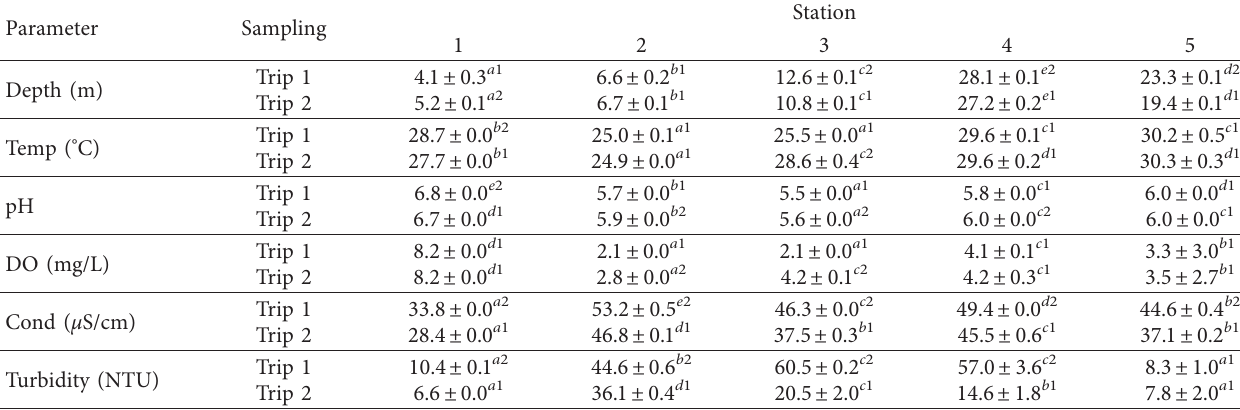
Table 4: In situ water quality of the Murum River during the dry (trip 1) and wet seasons (trip 2).